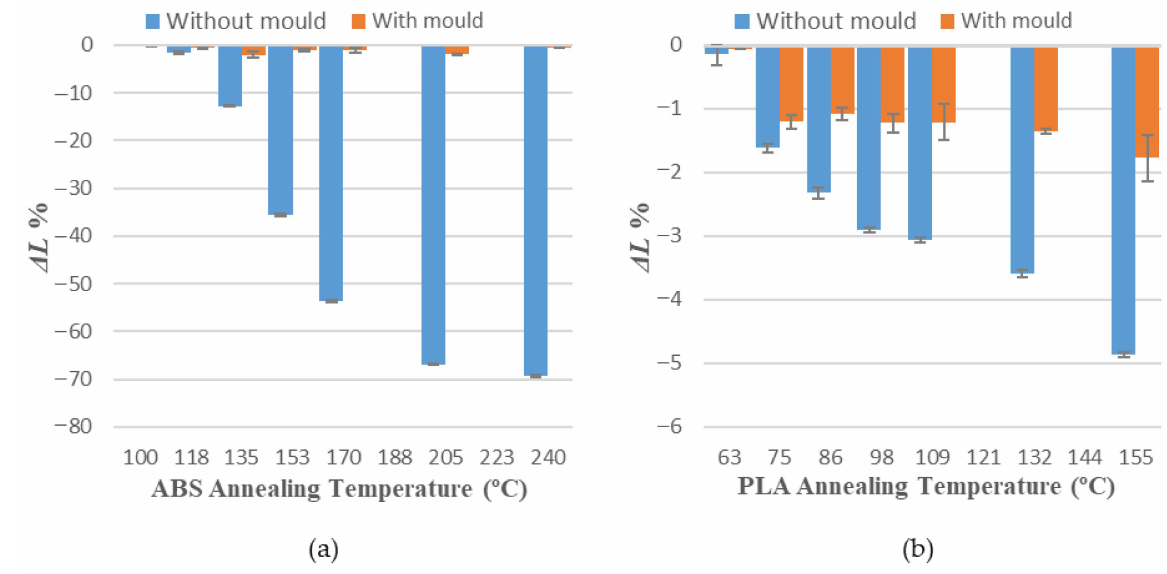
Figure 5. Length variations vs. annealing temperature: ( a ) ABS; ( b ) PLA.